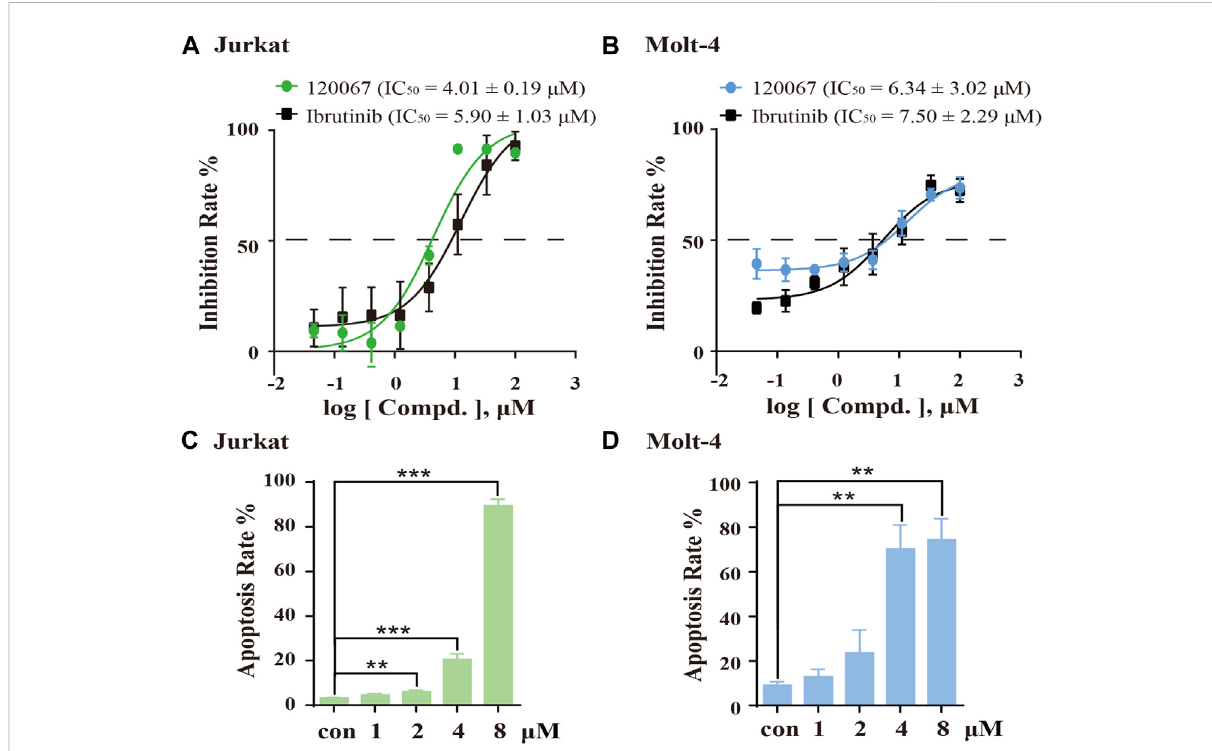
FIGURE 4 ASK120067inhibitedthegrowthandinducedapoptosisinT-cellleukemia.TheCCK-8assaywasusedtomeasuretheproliferationofJurkat (A) and Molt-4 (B) cells after exposure to various concentrations of ASK120067 or ibrutinib for 72 h. Experiments were undertaken at least twice independently, and results are the mean ± SD. Jurkat (C) and Molt-4 (D) cells were cultured with different doses of ASK120067 for 48 h and then stained with annexin V/propidium iodide. Percent apoptosis was analyzed by fl ow cytometry. Experiments were conducted thrice independently and a signi fi cant difference between single-agent groups vs. the control group was determined by the Student ’ s t -test. ** p < 0.01; *** p <